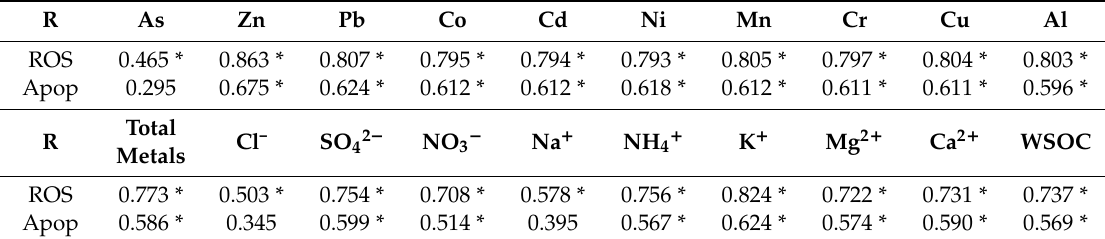
Figure 8. Apoptosis rates in the A549 cells exposed to di ff erent concentrations of PM 2.5. Early apoptosis is the percentage of cells stained by Annexin V, and late apoptosis is the percentage of cells stained by Annexin V and PI. The total apoptosis rate is the percentage of cells in the early and late stages of apoptosis. Di ff erent letters (a, b, c, d) indicate significant di ff erences among the five PM 2.5 treatments in each season ( p < 0.05). Data are the mean ± SD ( n = 3).